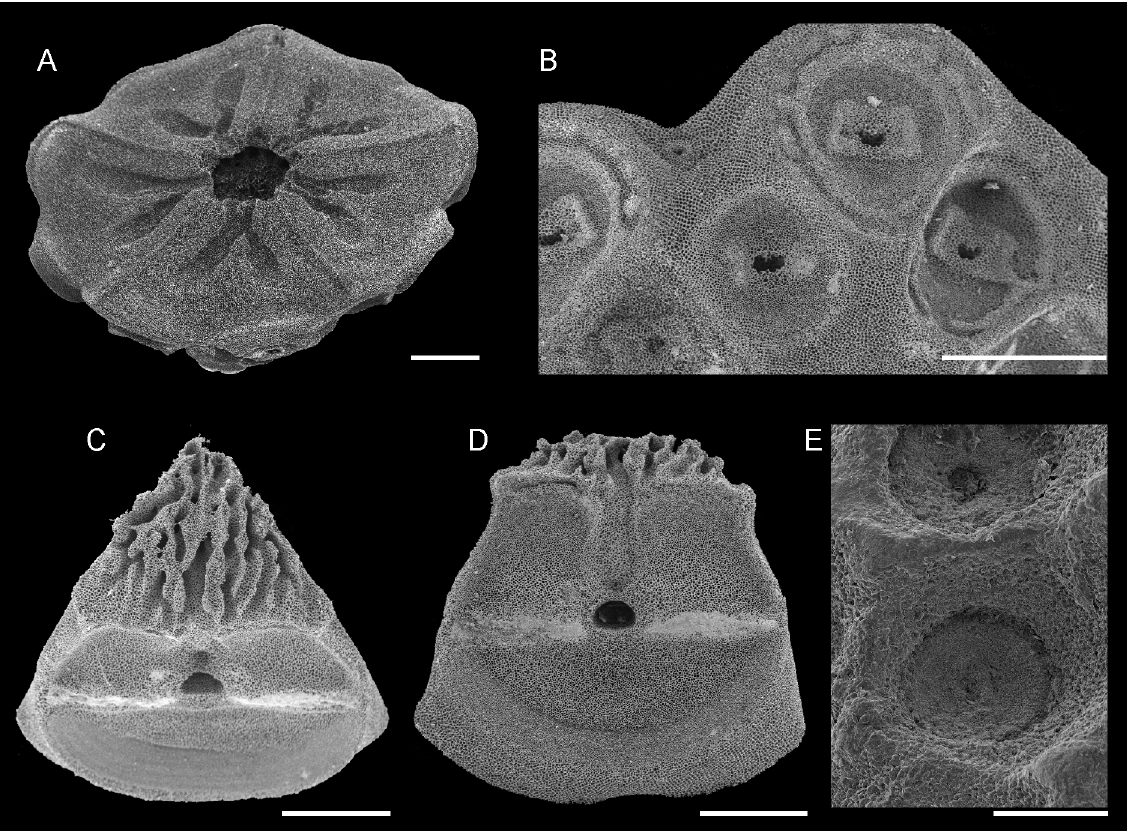
Fig. 3. Centrodorsal and radials in Himerometridae A.H. Clark, 1908. A – D . Himerometra robustipinna (Carpenter, 1881) (MNHN-IE-2012-862). A . Adoral side of centrodorsal. B . Cirrus sockets on lateral face of centrodorsal. C–D . Radials. C . Adoral view showing vermiculate grooves on inner face. D . Distal articular facet. E . Discometra rhodanica (Fontannes, 1877) from Picabrier (MHNL 20.062687), cirrus sockets on centrodorsal. Scale bars: A–D = 1 mm; E = 0.5